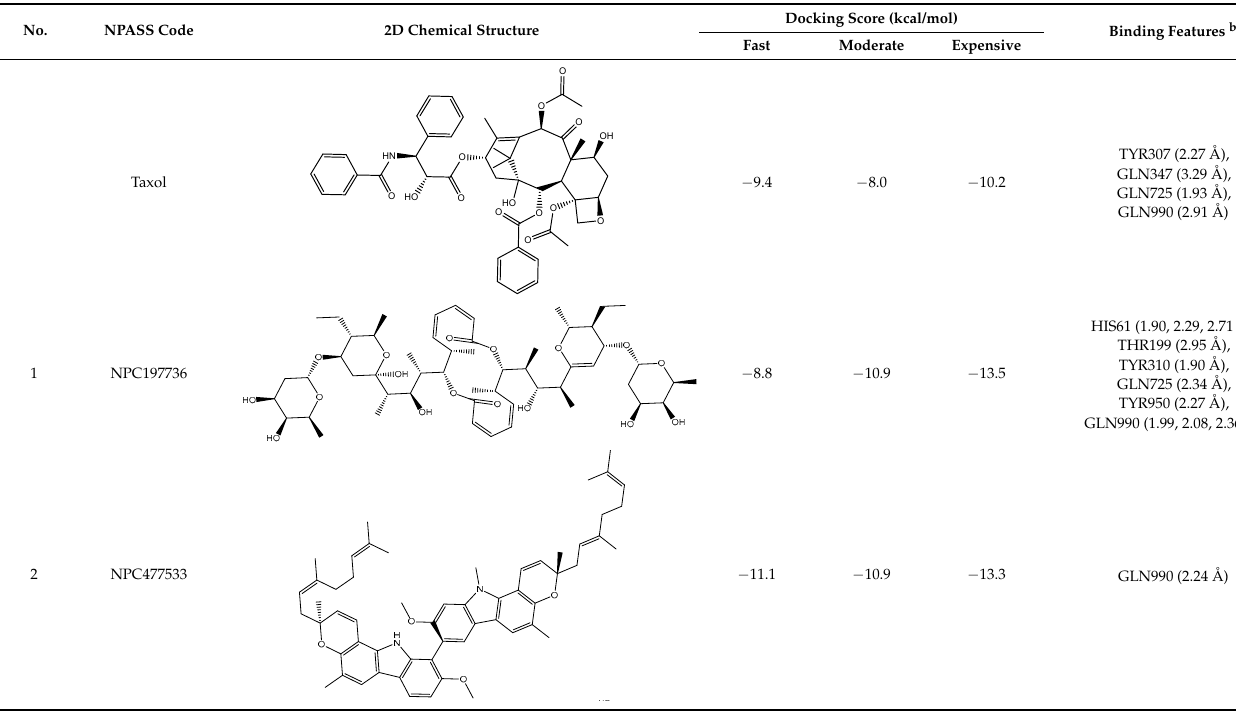
Table 1. Anticipated fast, moderate, and expensive docking scores (in kcal/mol), 2D chemical structures, as well as binding features for the top nine up-and-coming NPASS compounds against ABCB1 transporter. a